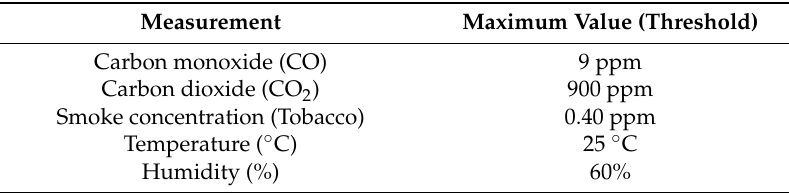
Table 3. Maximum Concentration Levels in Indoor